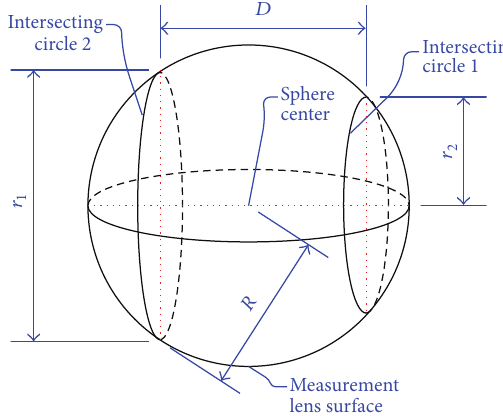
Figure 1: Schematic diagram of our method, where 𝐷 is distance between two parallel planes, 𝑅 is ROC of the sphere, and 𝑟 1 and 𝑟 2 are the radii of these two intersecting circles,